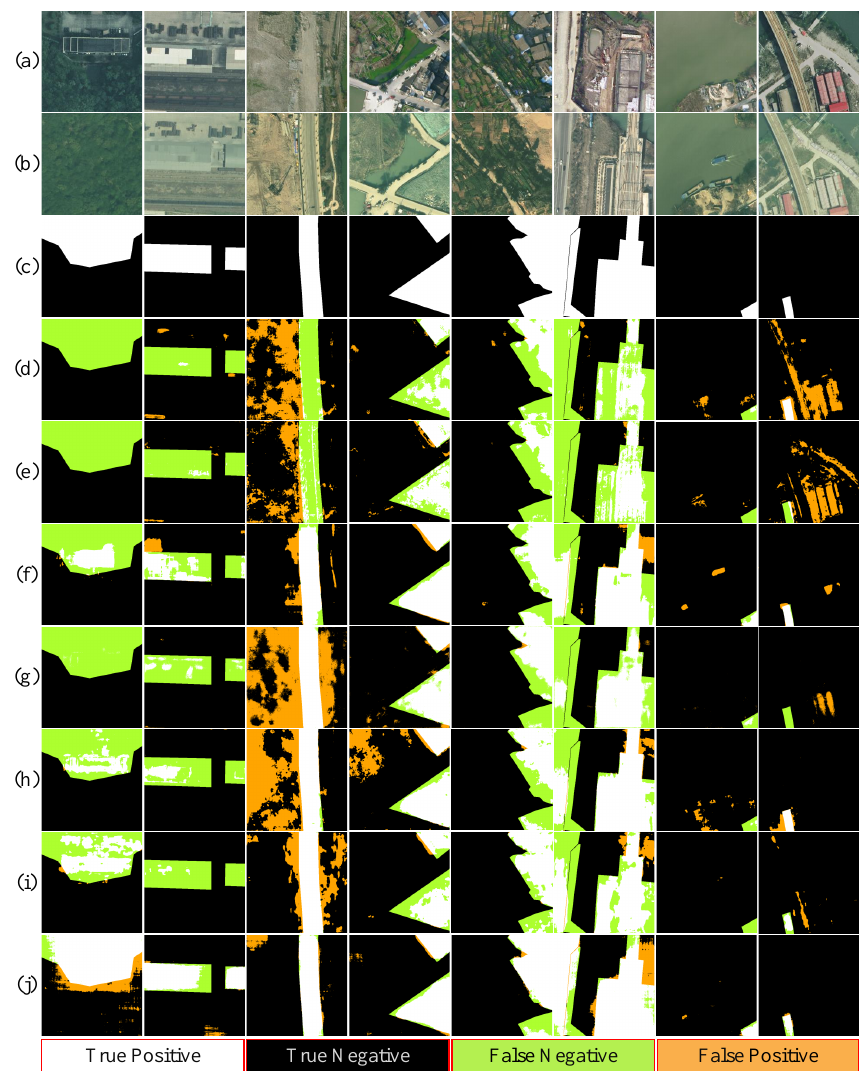
Figure 7. The results of the different methods on the Wenzhou data set: ( a ) T 1 -time image; ( b ) T 2 -time image; ( c ) ground truth image; ( d ) FC-EF [44]; ( e ) FC-Siam-Conc [44]; ( f ) SiUnet [45]; ( g ) SNUNet [55]; ( h ) SLGPNet [49]; ( i ) BIT [56]; and ( j ) proposed